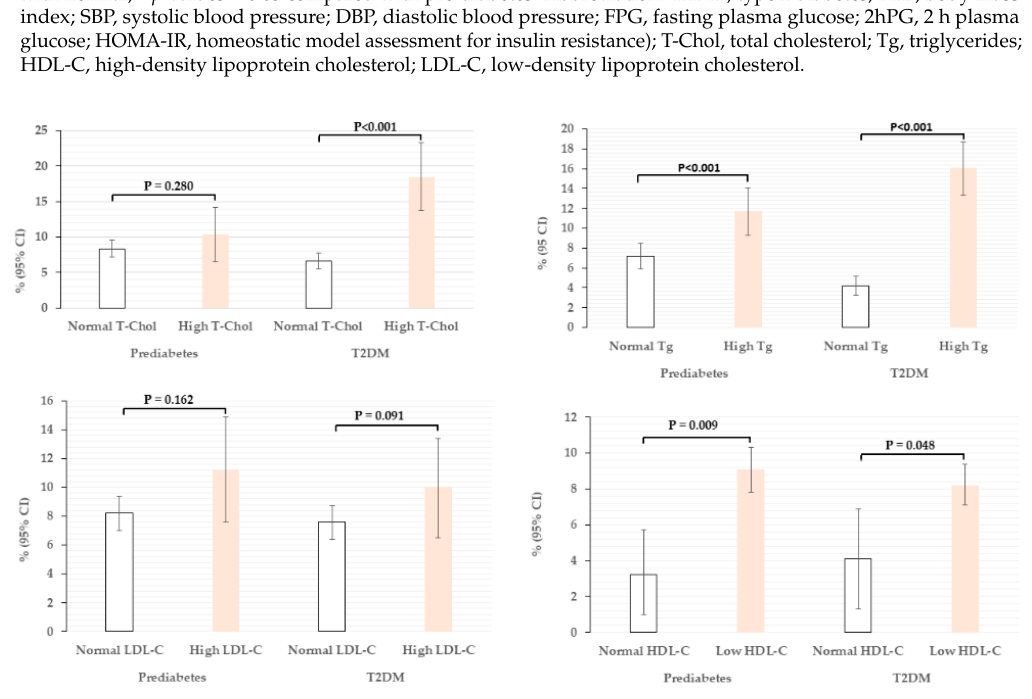
Figure 1. Prevalence of prediabetes and T2DM by different lipid parameters.